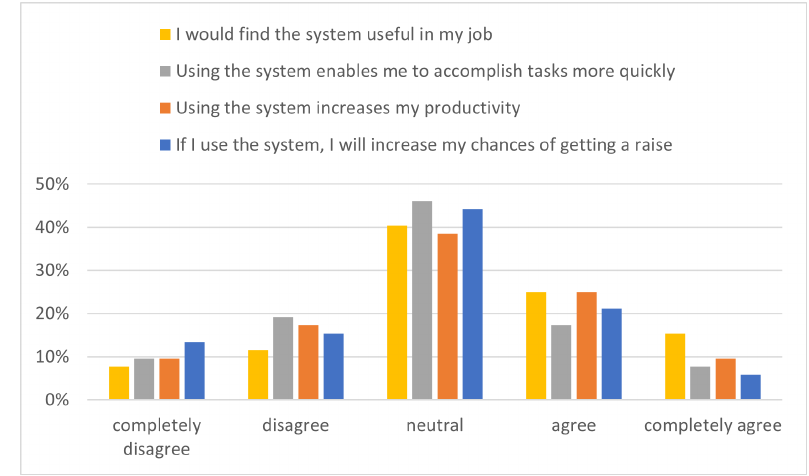
Figure 3. Survey results for ‘Perceived Usefulness’. Table 2. Numerical results for ‘Perceived Usefulness’.